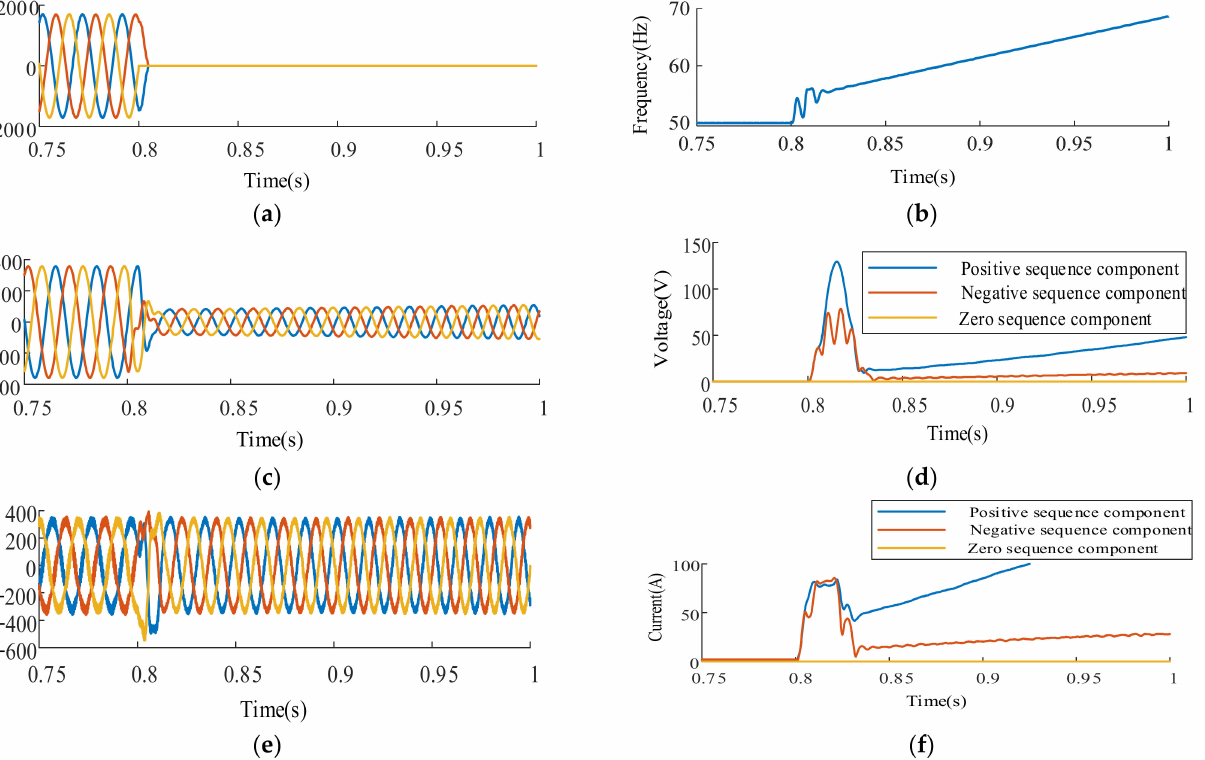
Figure 4. Islanding simulation waveforms with the loaded quality factor Q f = 2.5: ( a ) The current flowing into the grid; ( b ) System’s voltage frequency; ( c ) The voltage at the PCC; ( d ) The second harmonic symmetrical components of the measured voltage; ( e ) Inverter output current; ( f ) The second harmonic symmetrical components of the measured